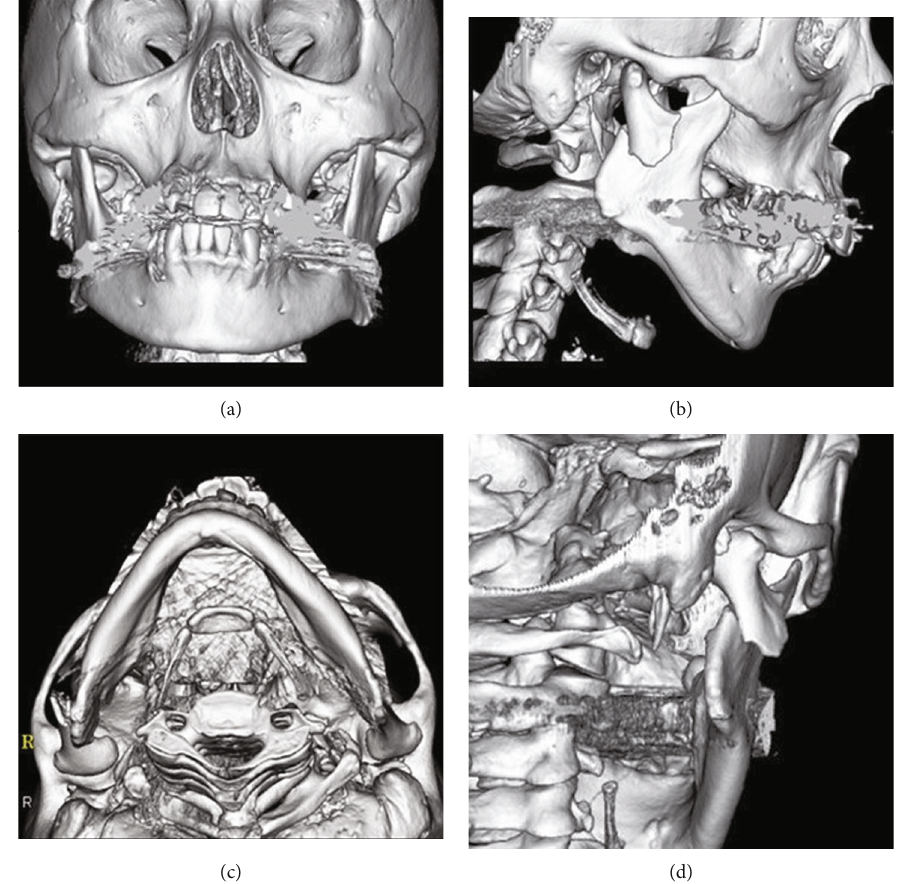
Figure 2: 3D-constructed CT image at the fi rst visit. (a) Front. (b) Right side. (c) Axial. (d) 45 degrees behind to the right. CT imaging shows a right mandibular condylar base fracture and lateral dislocation of the fracture fragment. No fractures are observed except for those of the mandible. No fractures of the alveolar bones of the upper and lower jaws are also observed. No tooth fracture is